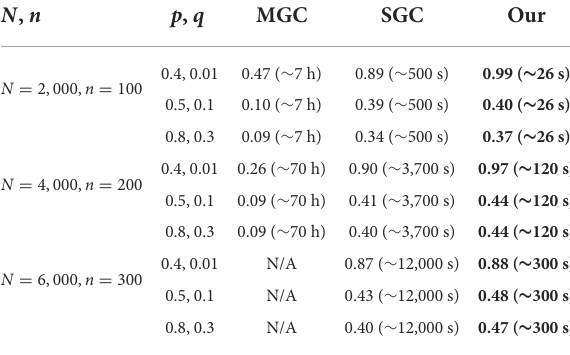
The number in parenthesis shows the average running time per run. The last case for MGC is omitted (noted as N/A) due to the running time limit (we set it as 100 h).